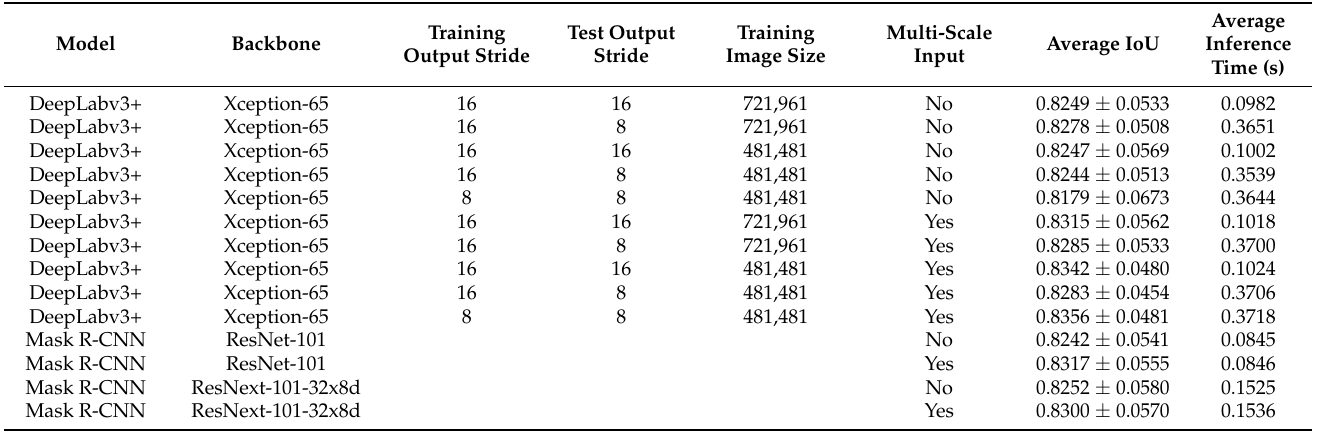
Table 2. Model performance with various training